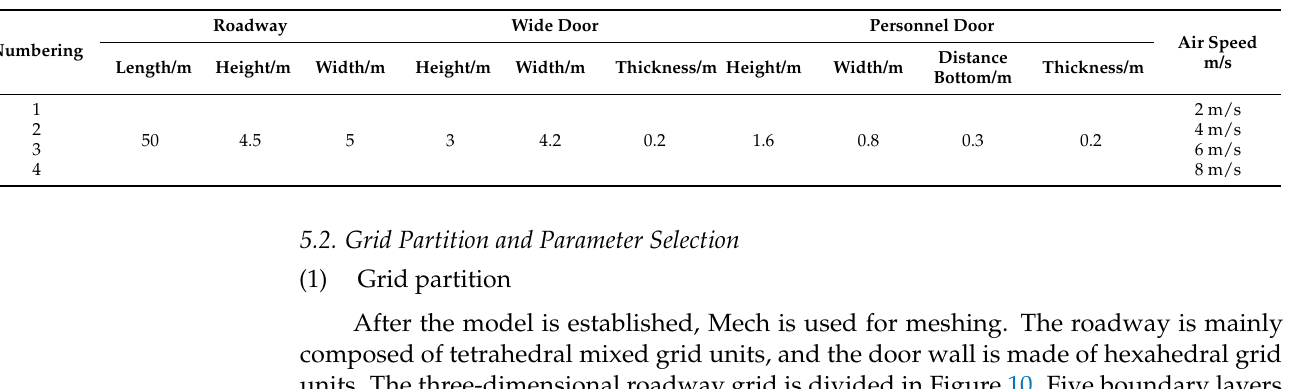
Figure 9. Three-dimensional roadway model of wide door and personnel door. ( a ) Wide door opening; ( b ) personnel door opening. Table 8. Three-dimensional roadway model size scheme.